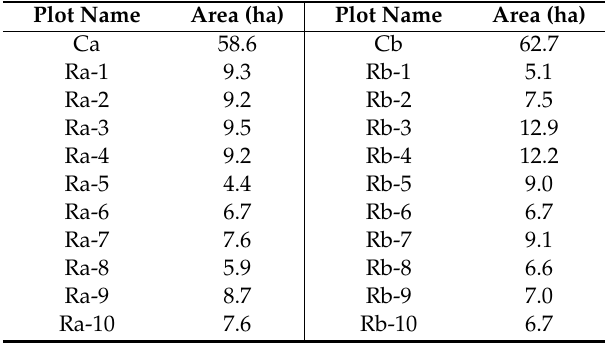
Table 1. The size of paddocks in the grazing experiment: replications a and b of continuous (Ca and Cb) and rotational (Ra and Rb)